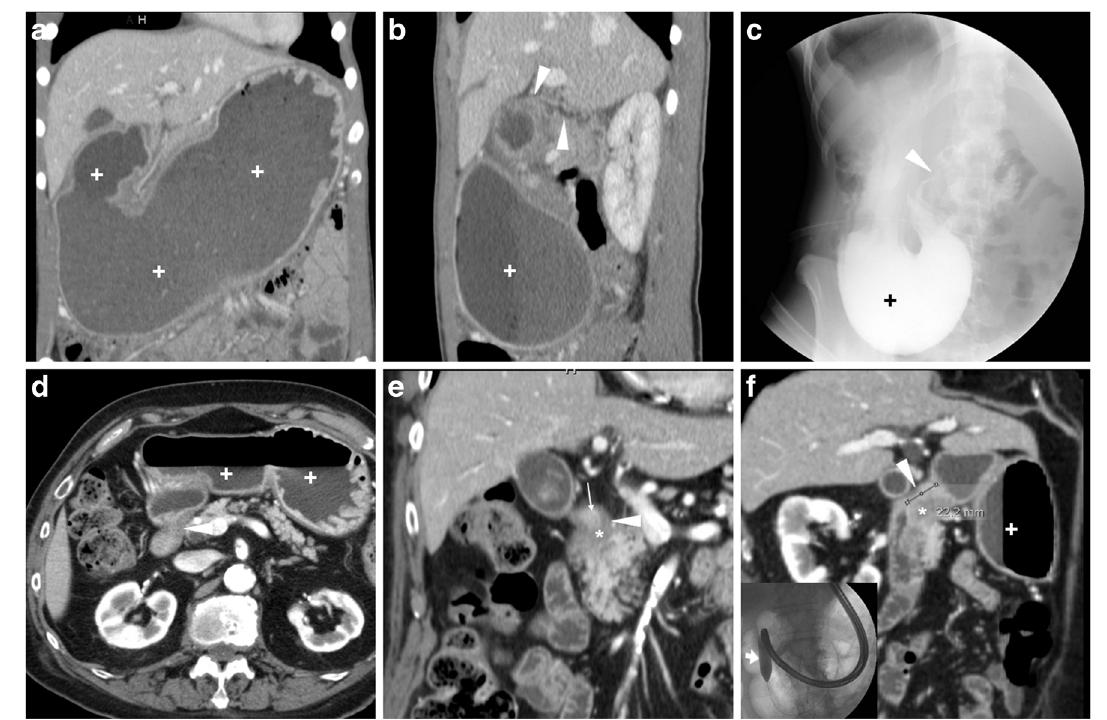
ulcers with bioptic finding of severe acute and chronic inflammation. A 88-year-old diabetic male suffered from vomiting, epigastric pain and dark stools. Contrast-enhanced CT ( d … f ) confirmed radiographic finding of gastric dilatation unrelieved by nasogastric tube, with intraluminal stagnant fluid (+) and depicted a 2-cm pyloric-duodenal stricture (arrowheads in e , f ) with subtle submucosal hypoattenuation (*) and mucosal hyperenhancement (thin arrow in e ) but no signs of